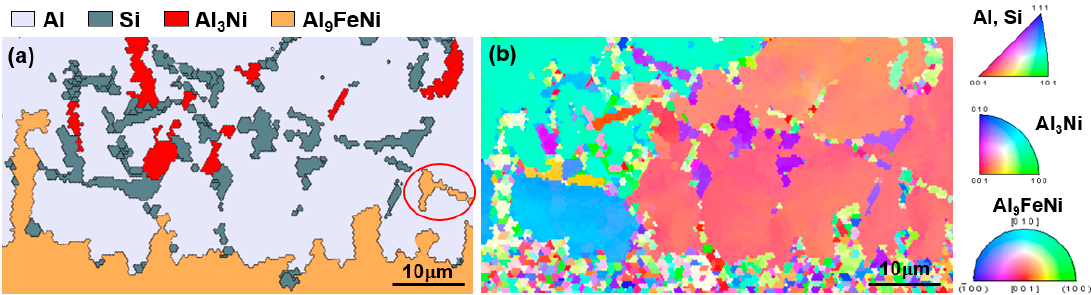
Figure 3. Electron backscatter diffraction (EBSD) analysis results using Chi-Scanning for the solidification layer (rectangular “A” in Figure 1): ( a ) Phase map and ( b ) inverse pole figure (IPF). Table 2. Energy-dispersive X-ray spectroscopy (EDS) analysis results of phases denoted as 1–11 in Figure 2. No. at%/wt%